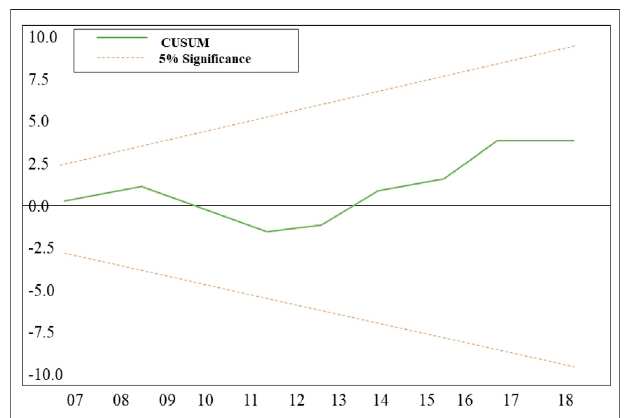
FIGURE 1 | CUSUM coef fi cient stability